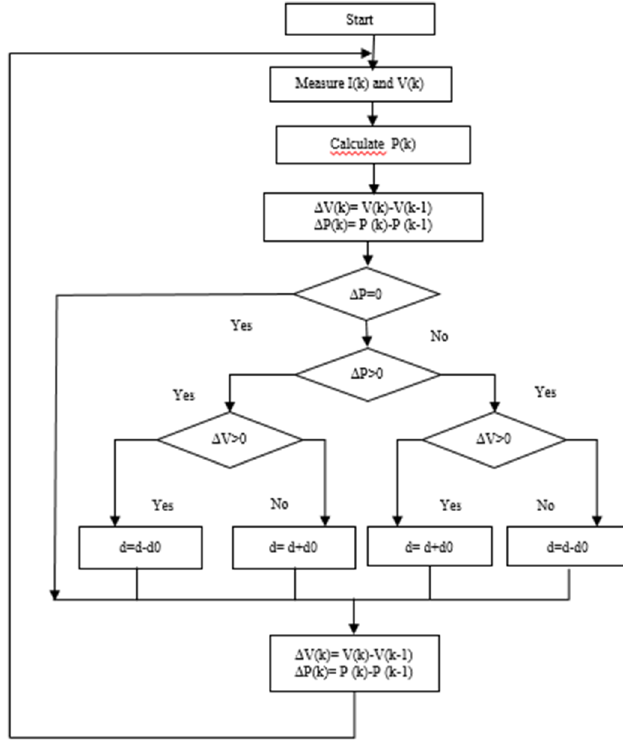
Fig. 7. Perturb & Observe classic